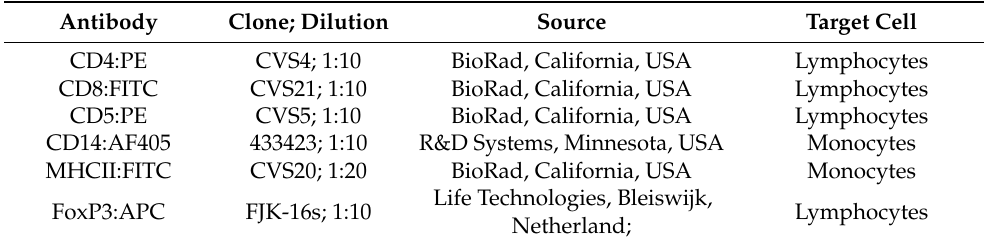
Table 1. List of monoclonal antibodies used for labeling peripheral blood mononuclear cells (PBMCs) for flow